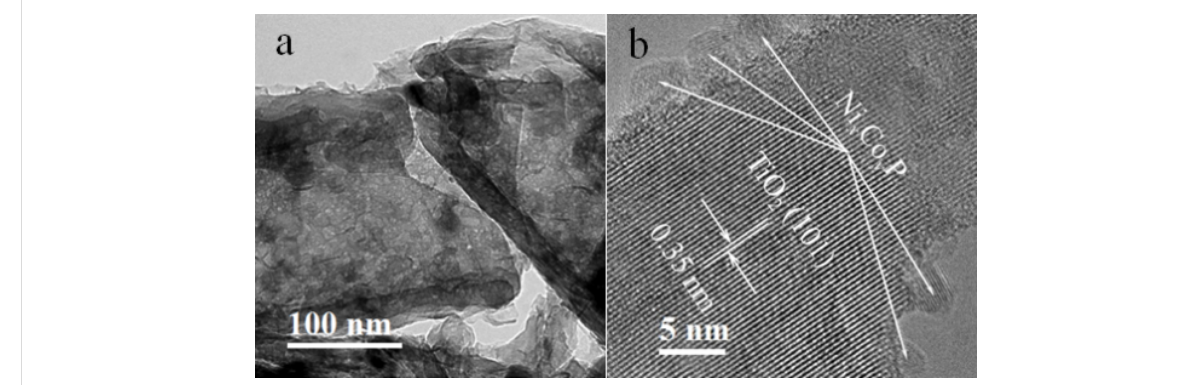
Figure 3: (a) TEM and (b) HR-TEM images of the Ni x Co y P/TNAs.